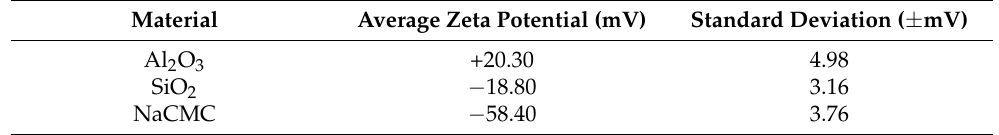
Table 1. Zeta potentials of the ceramic particles and the polymeric